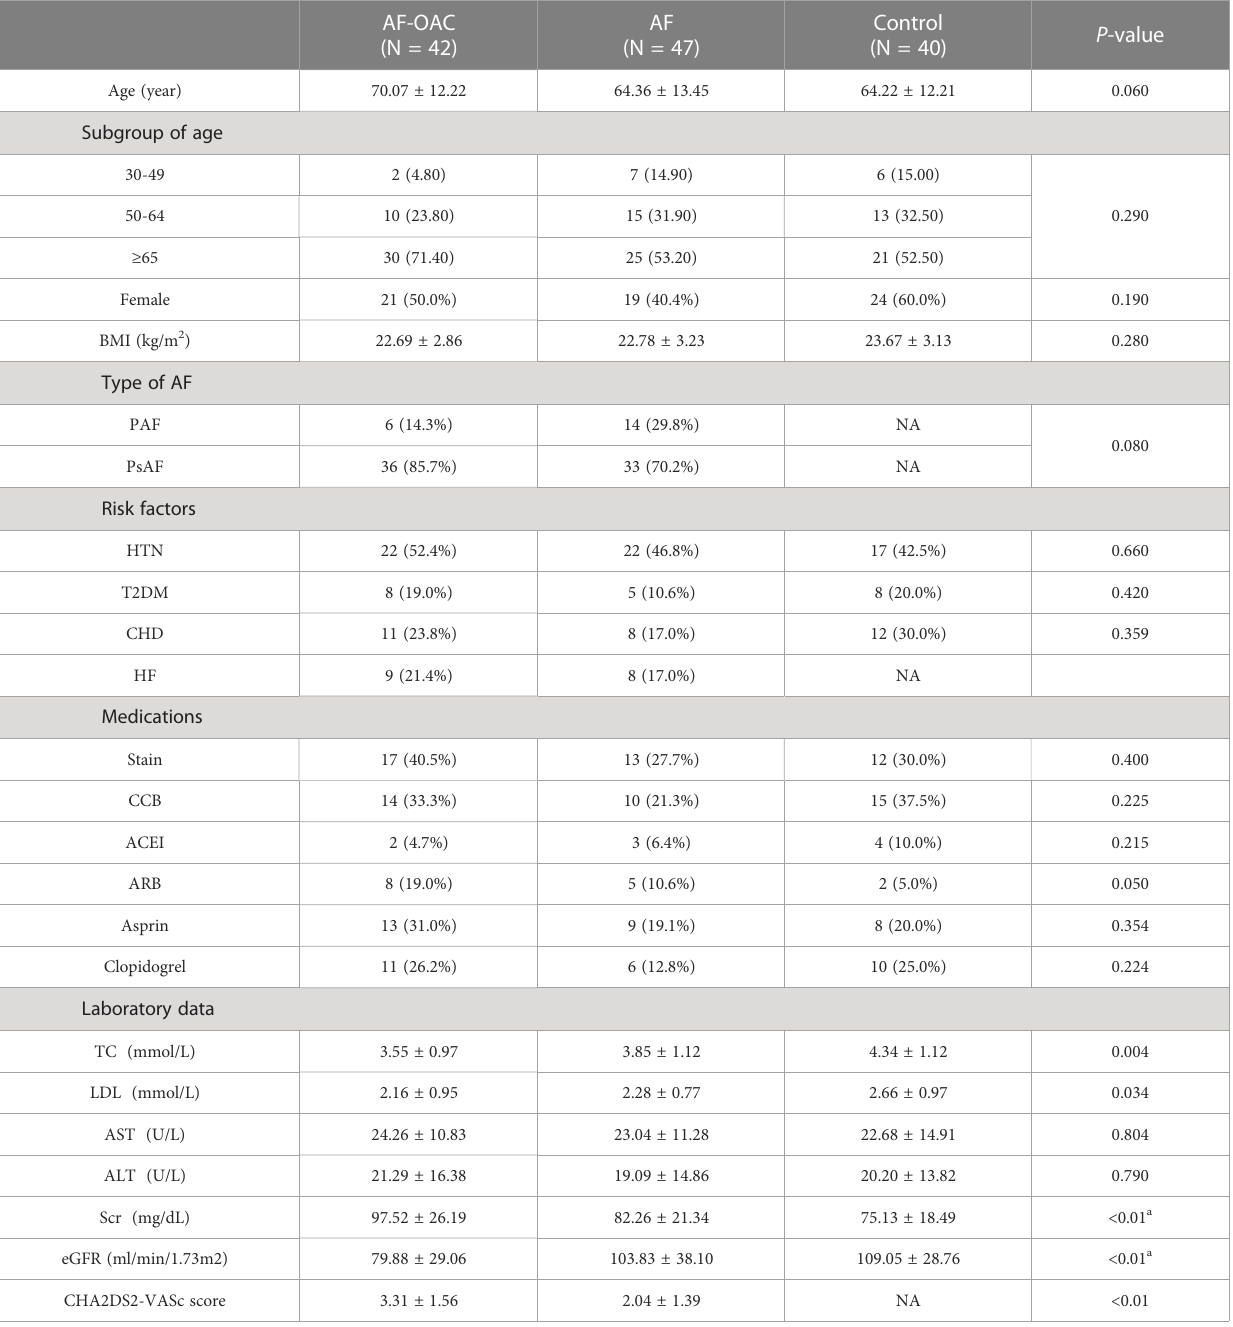
TABLE 1 Baseline characteristics of the study cohort[ x ̅ ± S,